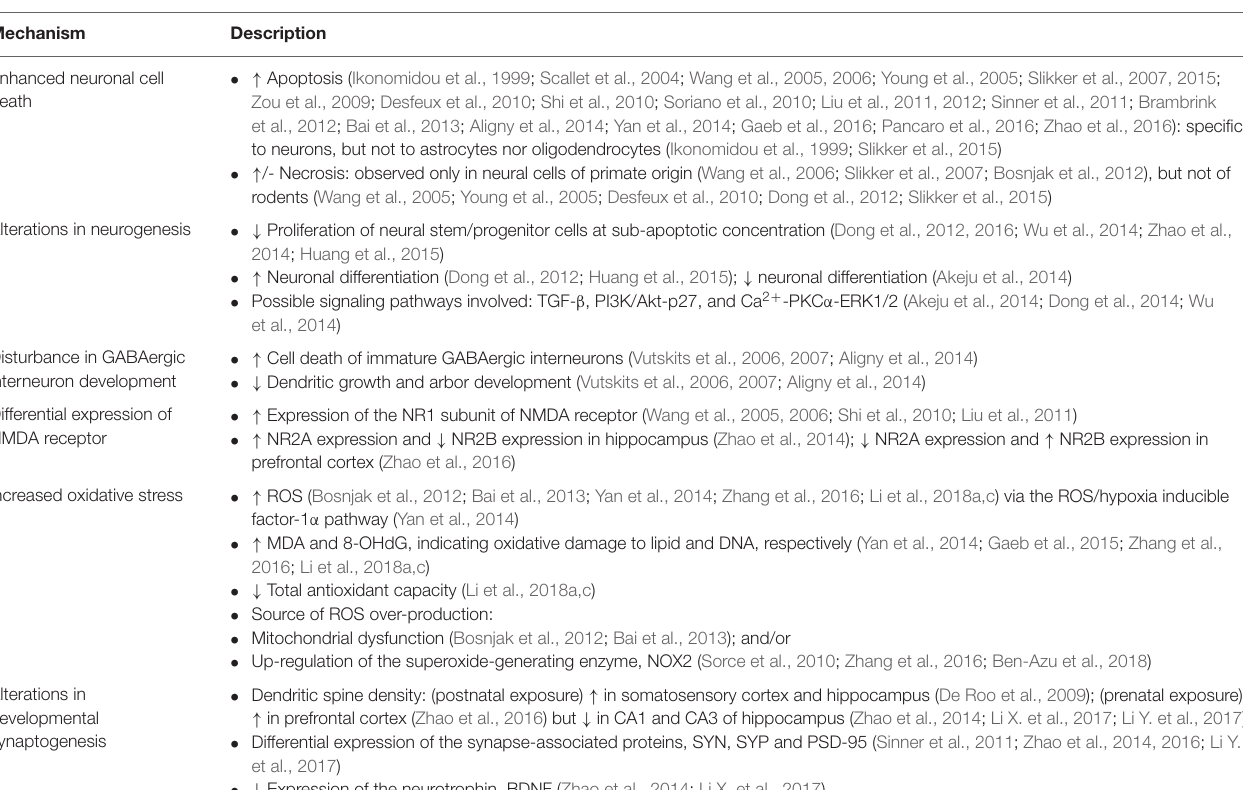
TABLE 3 | Summary of major possible mechanisms of ketamine-induced neurotoxicity to the developing brain.